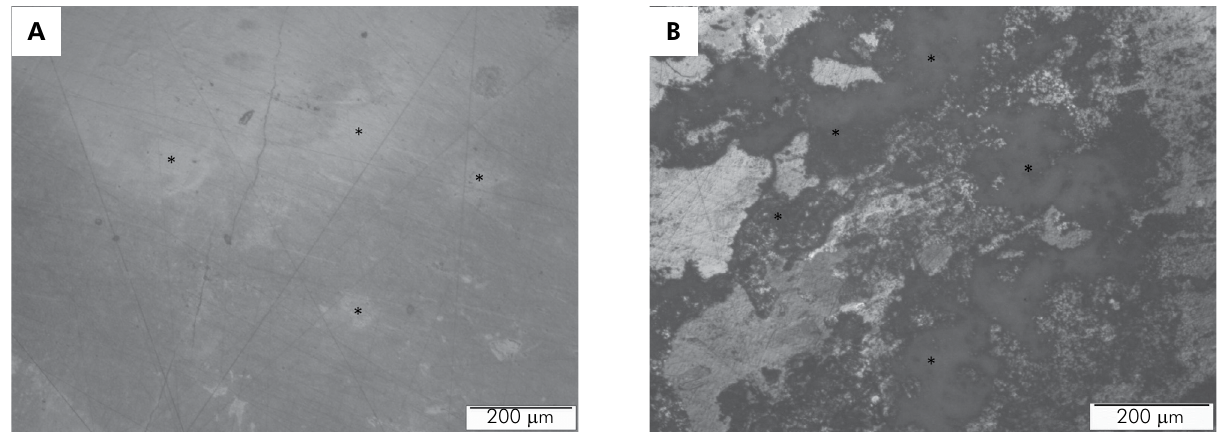
Figure 4. Optical microscopy image (100×) of NaF and TiF (B) TiF group with continuous layer formation on surface. *Layer formed after varnish 4